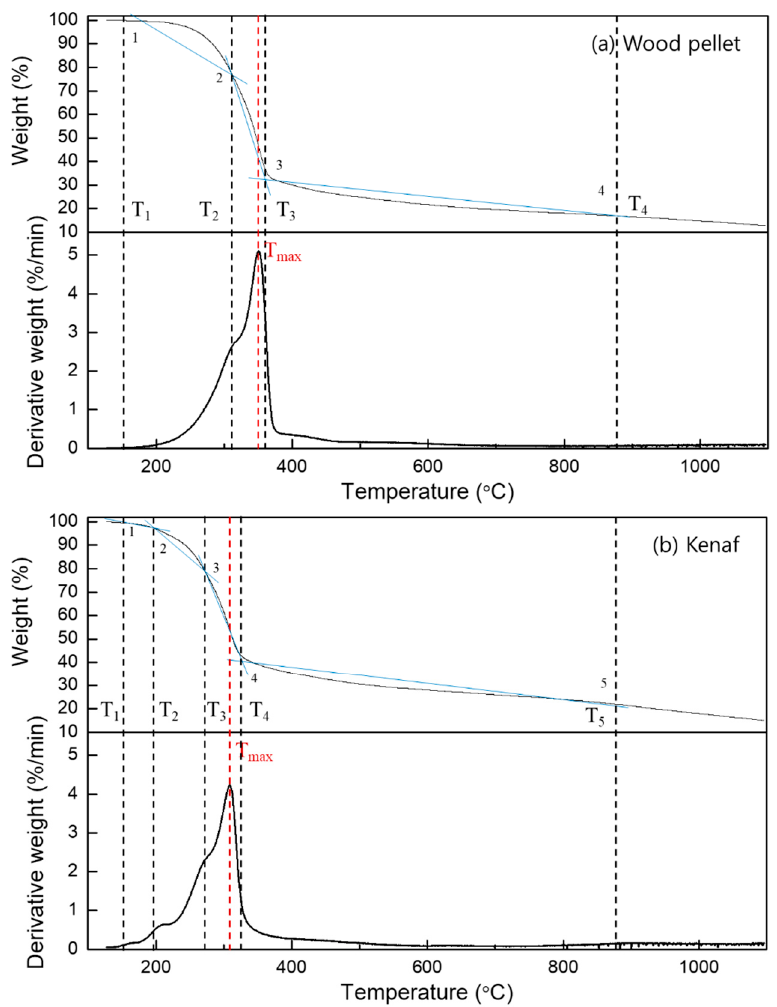
Figure 3. Thermogravimetry (TG) and derivative thermogravimetry (DTG) curves of biomass samples under pyrolysis conditions; ( a ) wood pellets and ( b ) kenaf.